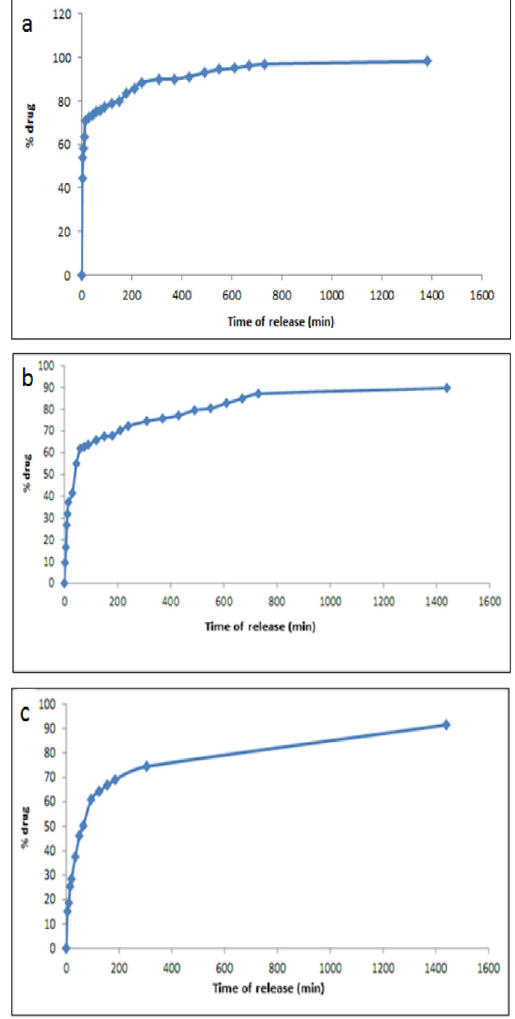
Fig.6. In vitro release profiles of morphin a) from conventional nanofibers, b) from coaxial nanofibers and c) from sandwich